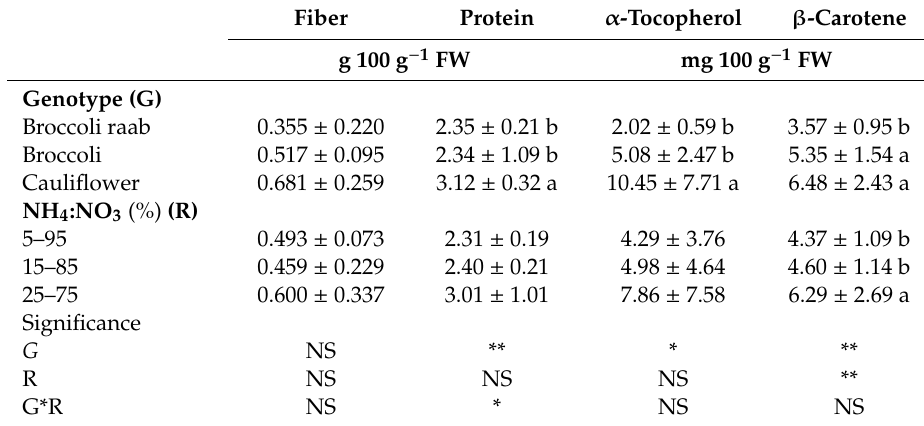
Table 7. Effects of genotypes and NH 4 :NO 3 ratio on fiber, protein, α -tocopherol and β -carotene content (second experiment).